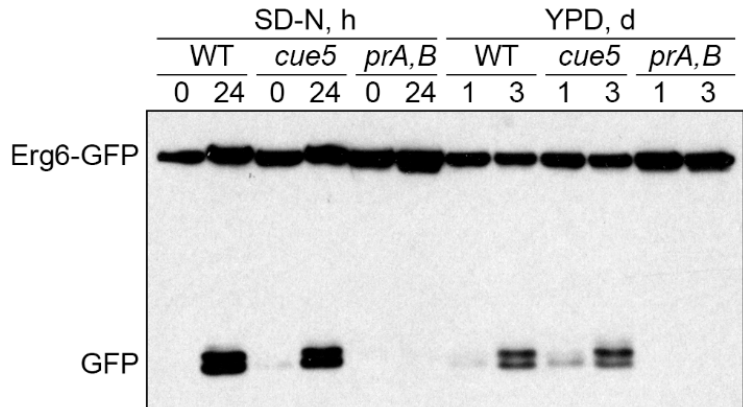
Figure 5. Cue5 is dispensable for S-phase lipophagy. The WT, cue5 and prA,B cells expressing Erg6- GFP were grown in YPD medium and equal biomass was taken at 1 d and 3 d for testing S-phase lipophagy. Ponceau S staining (Figure S4) was used as a loading control. A fraction of cells from “YPD, 1 d” cultures was transferred to SD-N medium at OD 600 = 1 and equal volumes of cultures were taken at 0 h and 24 h for testing N-starvation lipophagy (loading control not applicable).